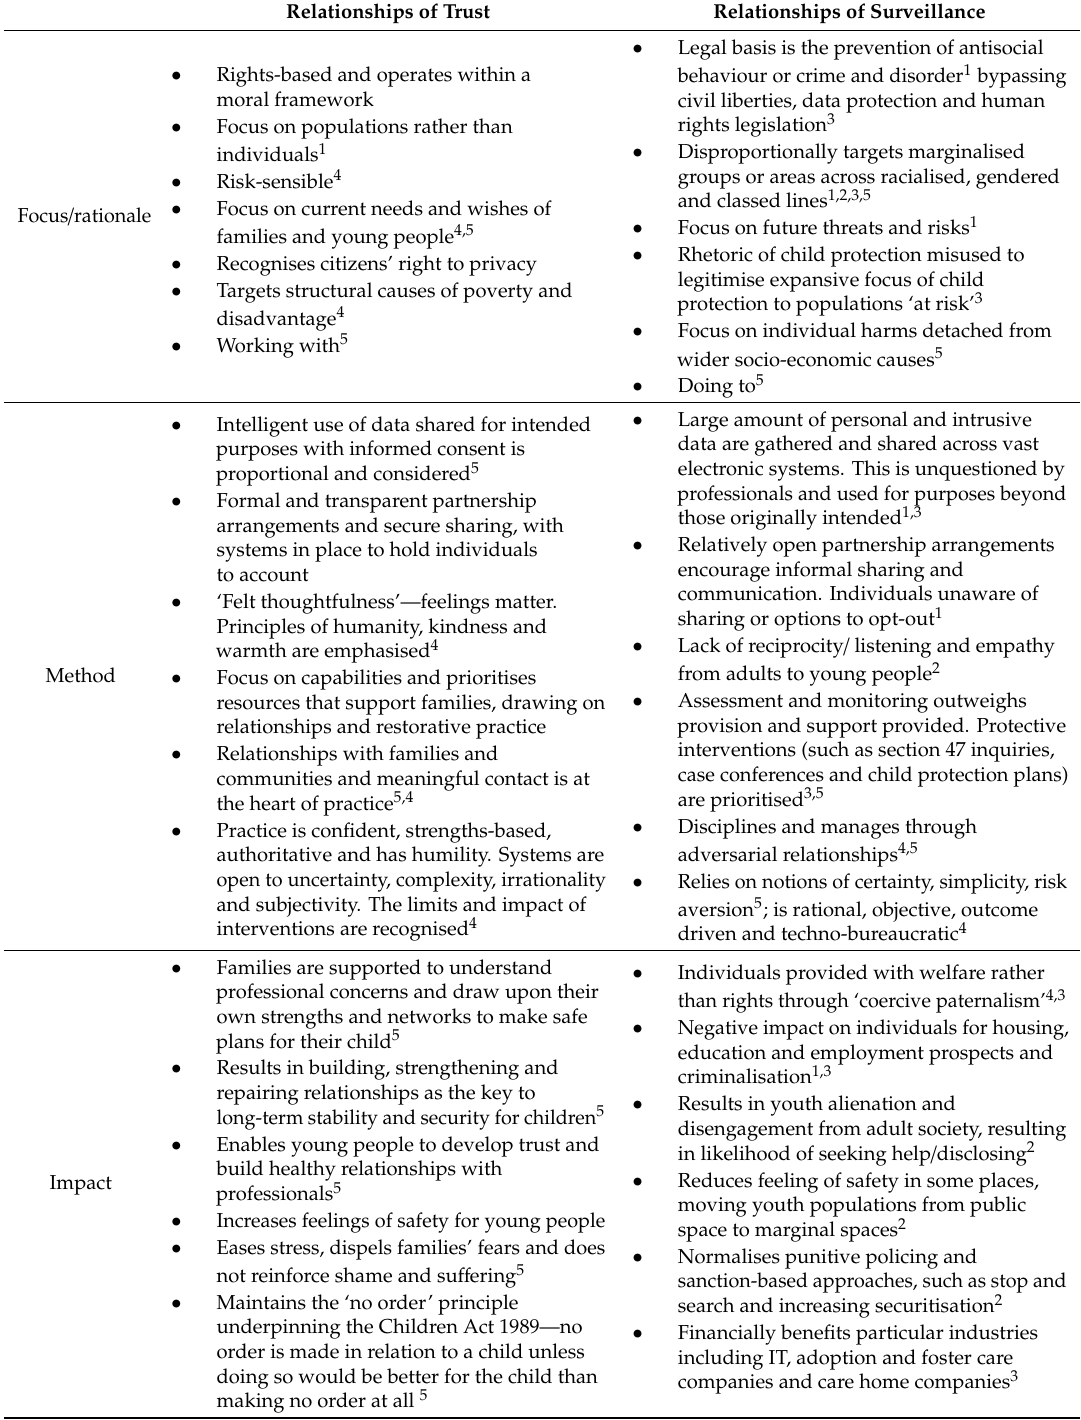
Table 1. Key components of five studies (numbers indicate